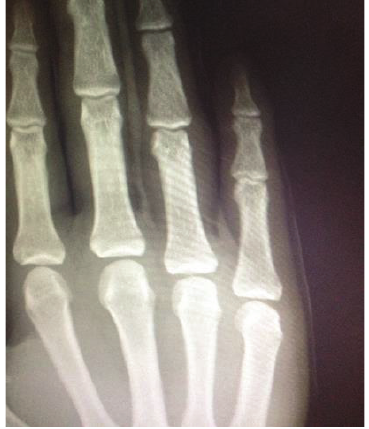
Figure 4: X-ray showing reduced finger.